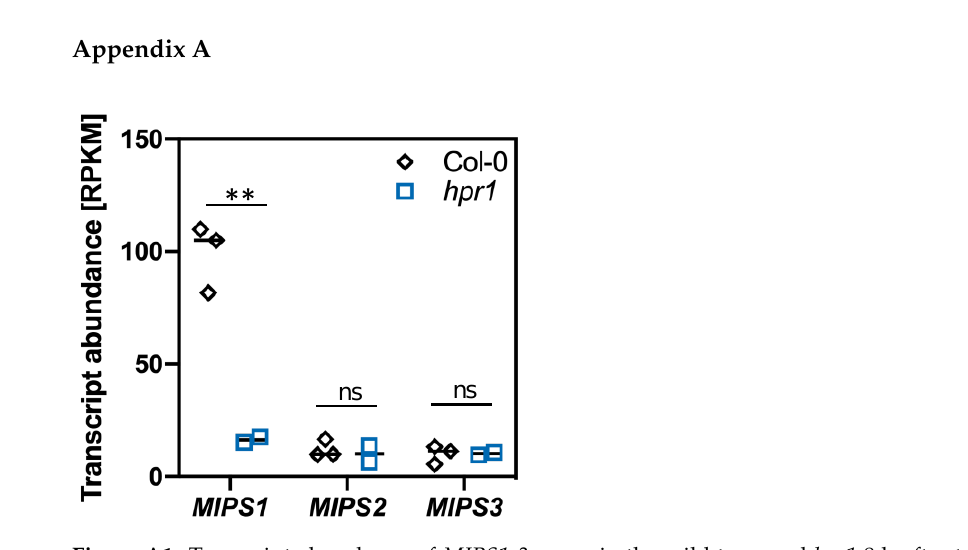
Figure A1. Transcript abundance of MIPS1-3 genes in the wild type and hpr1 8 h after transition from elevated (1% CO 2 in air) to normal ambient (0.038% CO 2 in air) CO 2 conditions. Transcript abundances are given as individual values of each biological replicate and mean of RPKM (reads per kilobase of transcript per million reads mapped). Significance was tested with the two-tailed Student’s t -test. ** p < 0.01; ns, not significant. Data was extracted from a previous study [7].